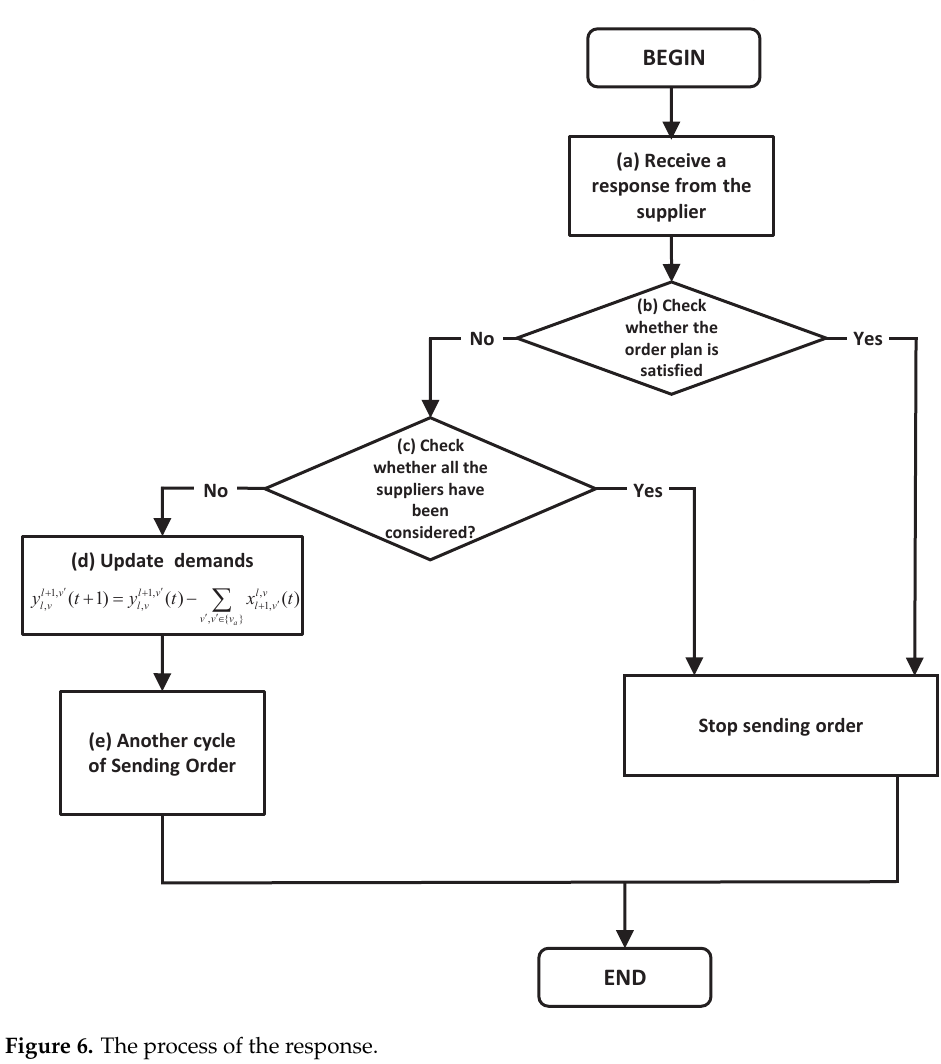
Figure 6. The process of the